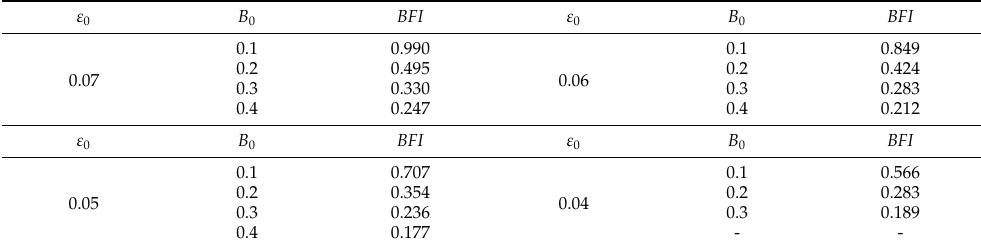
Table 4. The values of BFI under the settings of the Gaussian spectrum.